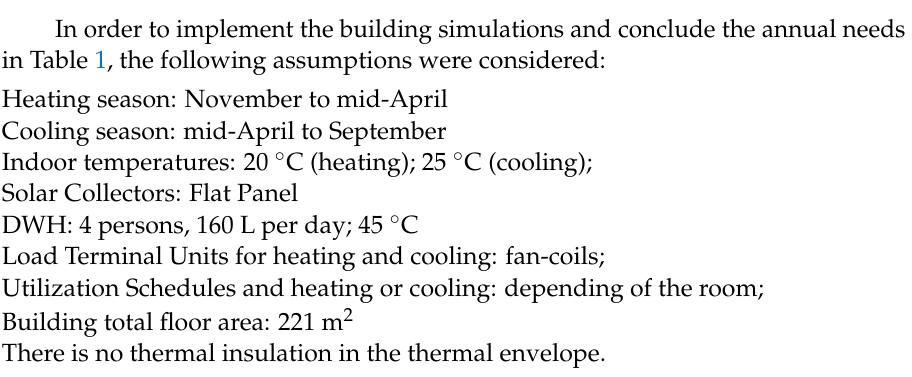
Figure 3. External view of the building—East. ( A ) = actual building, ( B ) = geometric model.